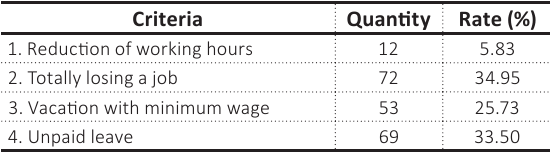
Table 2. Vulnerabilities of livelihood to employment Criteria